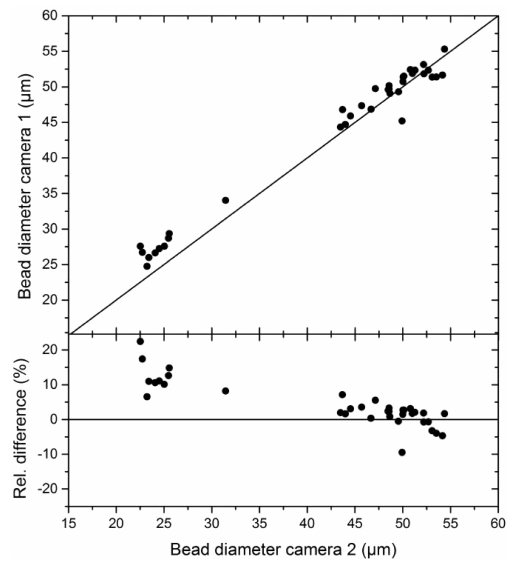
Figure 11. Comparison of the bead diameters deduced from the images of camera-telescope assembly 1 and